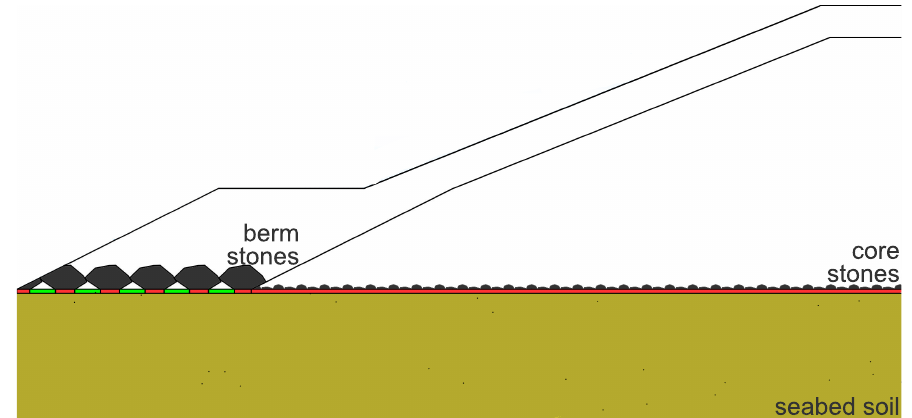
Figure 2. Sketch of assumed load distribution under a porous structure: red zones refer to contact areas, where the load is transferred to the soil. Green zones refer to unloaded